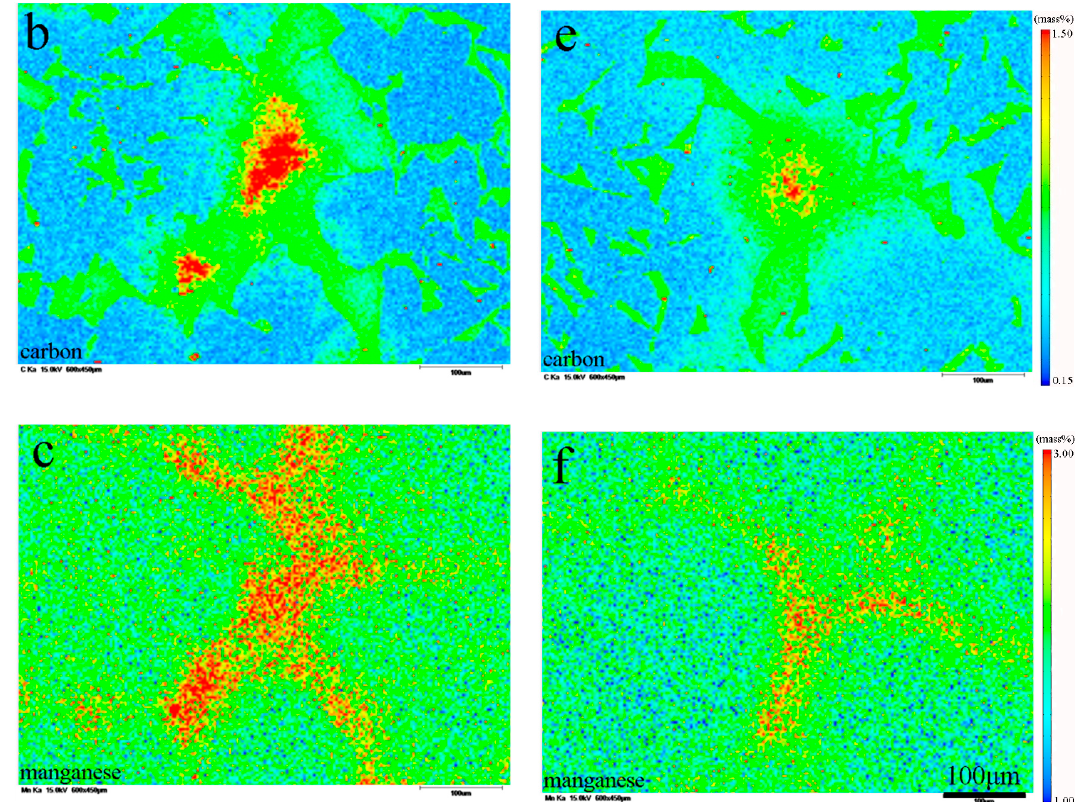
Figure 2. Two-dimensional mapping of solute elements in the billet sample: ( a – c ) Billet 1; ( d – f ) Billet 2.